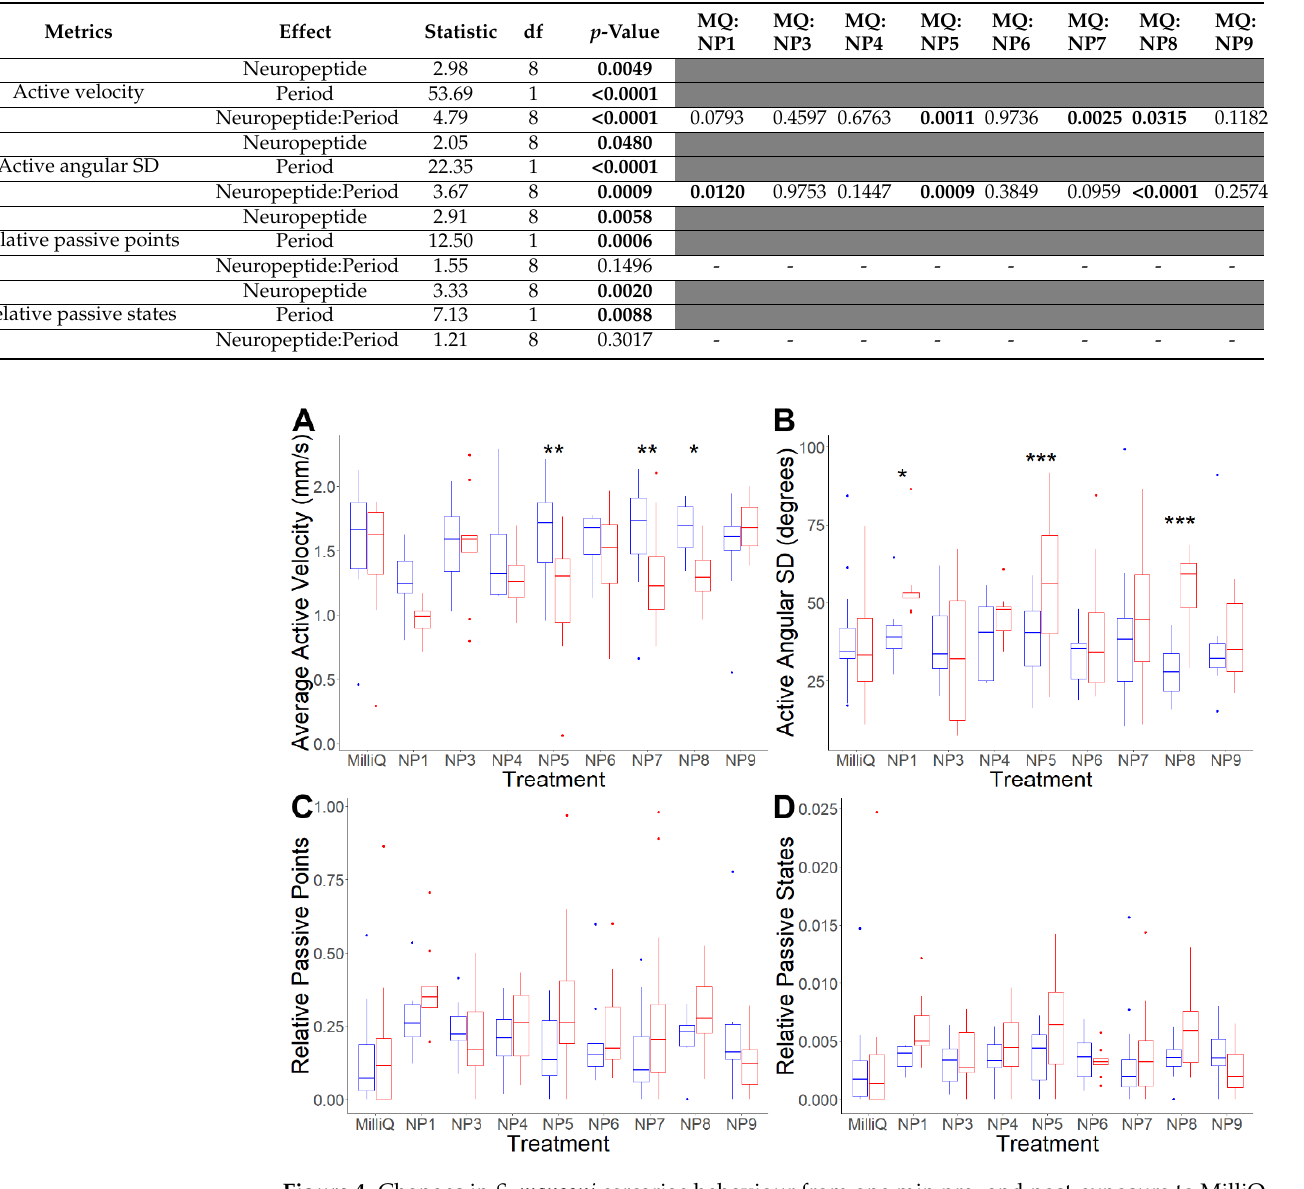
Figure 4. Changes in S. mansoni cercariae behaviour from one min pre- and post-exposure to MilliQ water and 3 mg/mL NP1, NP3, NP4, NP5, NP6, NP7, NP8 and NP9. ( A ) Average active velocity (mm/s); ( B ) active angular SD (degrees); ( C ) relative passive points; ( D ) relative passive states. Boxplot indicates median, 25th and 75th percentiles, minimum and maximum data with outliers represented by dots. A two-way ANOVA test was used to calculate p -values for the mixed-effects interaction of pre- and post-exposure to putative neuropeptide treatments against MilliQ water: * p- value < 0.05, ** p- value < 0.01, *** p- value < 0.001. Colour: blue: pre-exposure; red: post-exposure. Table 2. Two-way ART ANOVA results, comparing the effects of S. mansoni cercarial exposure to NP1, NP3, NP4, NP5, NP6, NP7, NP8, and NP9 at 3 mg/mL in MilliQ water one min pre- and post- exposure. Test statistics, degrees of freedom, and p -values for the main effects of putative neuro- peptide and period (pre- vs. post-exposure), and their interaction. If the interaction effect was sig- nificant, pairwise contrasts are included; testing analysed the significance of the change in behav- iour pre- vs. post-exposure between MilliQ and each of the putative neuropeptides. Metrics: active velocity, active angular SD, relative number of passive points and states. Significant data ( p -value < 0.05) is in bold. Metrics